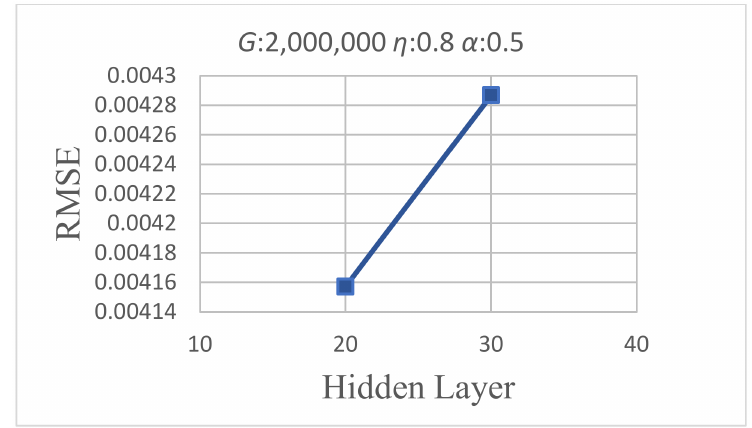
Figure 11. Number of hidden layer neuron variables for RMSE.